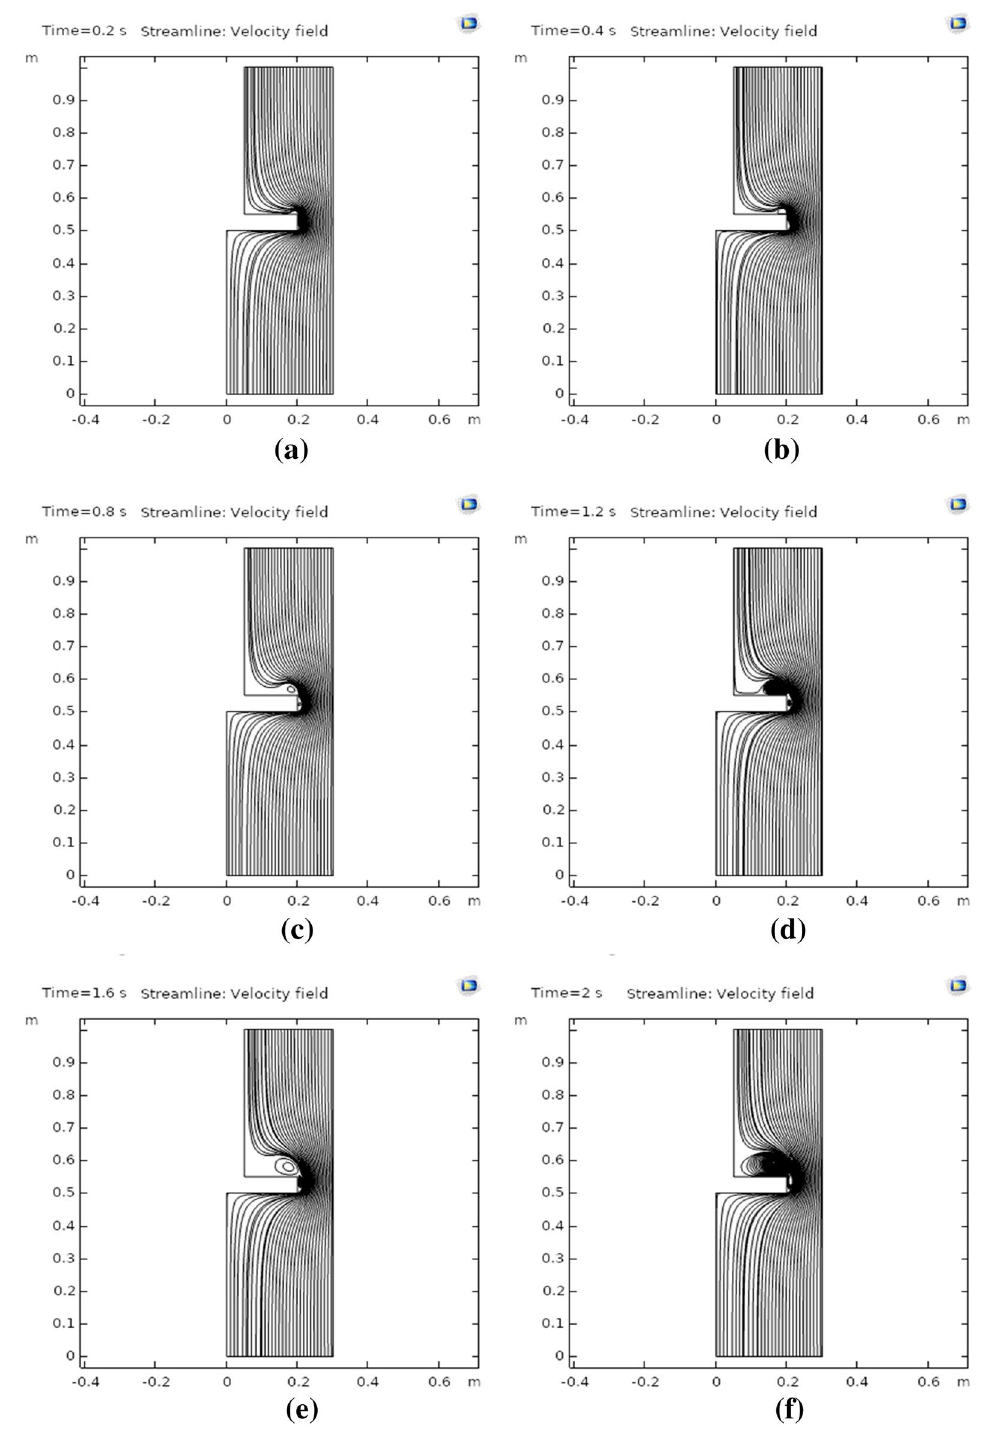
Figure 5. (a) Streamlines at 0.2 s, (b) streamlines at 0.4 s, (c) streamlines at 0.8 s, (d) streamlines at 1.2 s, (e) streamlines at 1.6 s, (f) streamlines at 2.0